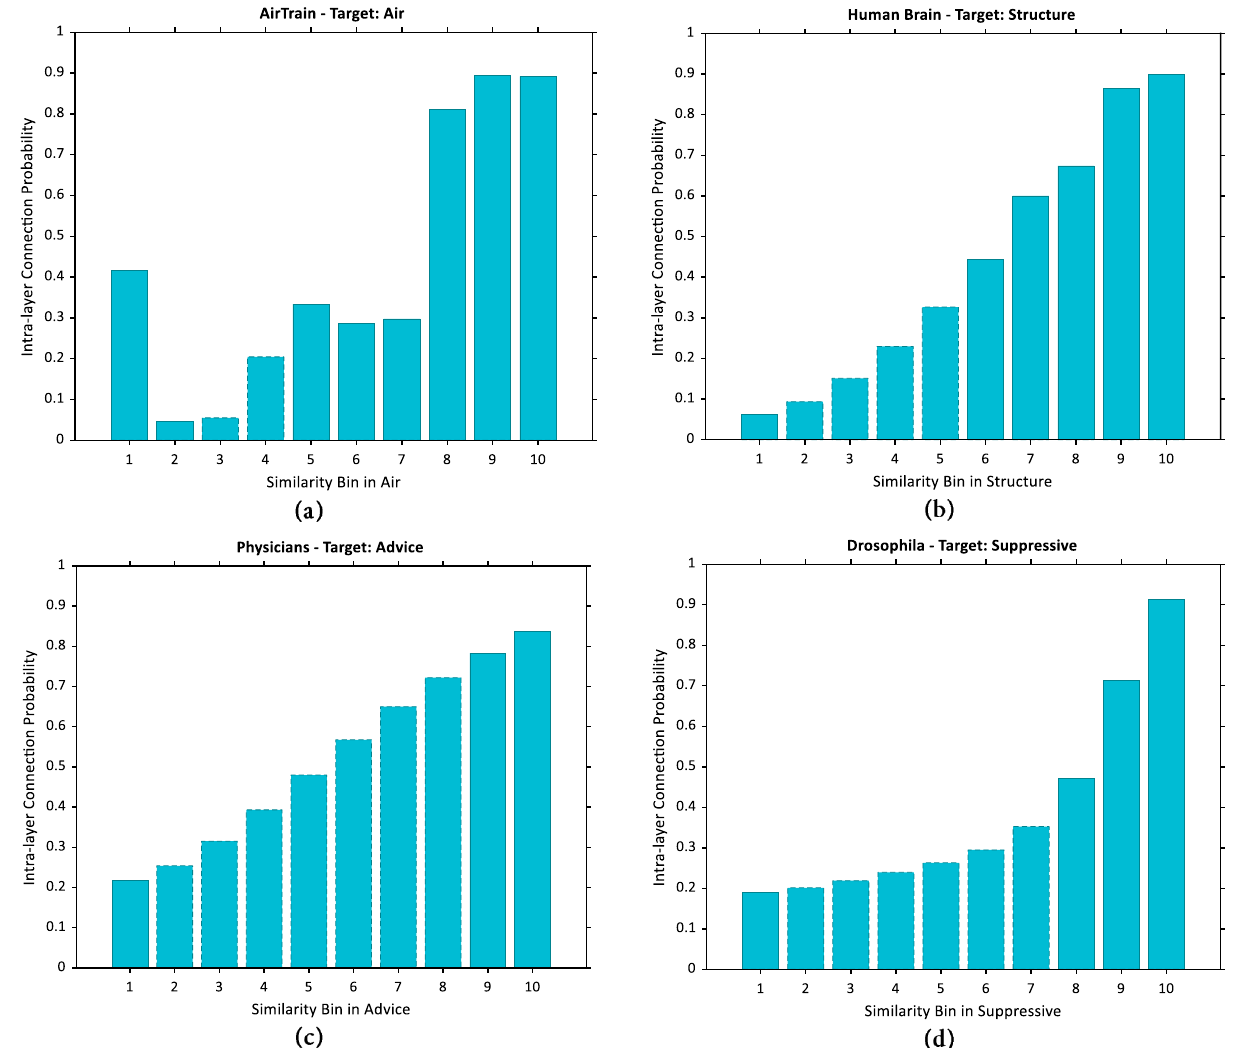
Figure 1. Intra-layer connection probability in target layer bins. Intra-layer connection probability or fraction of node pairs in a bin that are linked in layer ( a ) ‘Air’ of the network Air/Train, ( b ) ‘Structure’ of Human Brain, ( c ) ‘Advice’ of Physicians, ( d ) ‘Suppressive’ of Drosophila. Bars with dashed lines represent imputed